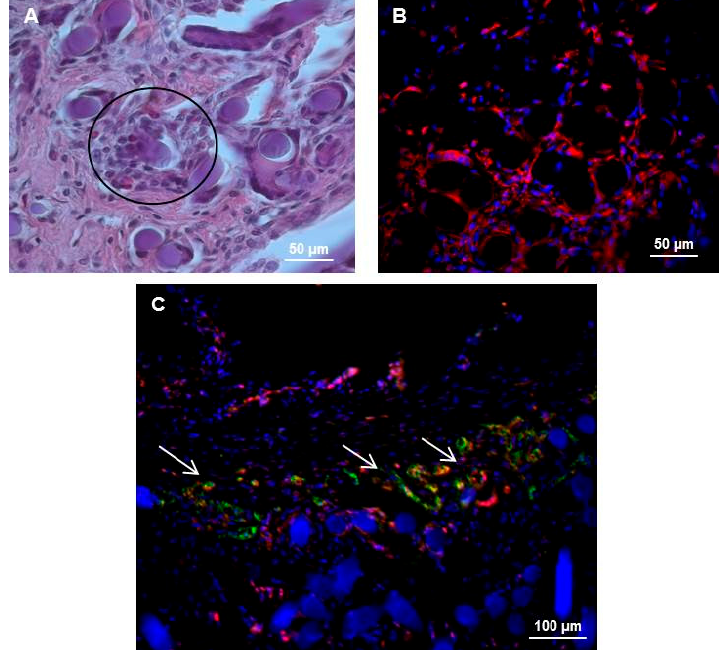
Figure 6. ( A ) The hematoxylin and eosin (H&E) staining of pocket-scaffold enriched with rat hepatocytes and hMSCs showing the presence of hepatocytes (black circle) organized into clusters inside the HA fibers of the pocket-scaffold; ( B ) Immunofluorescence (IF) staining of Vimentin (red) in pocket-scaffold enriched with rat hepatocytes and hMSCs revealing cytoskeleton of mesenchymal cells. Nuclei (blue) stained with Hoechst; ( C ) Double IF staining showing VWF-positive endothelial cells (green) and CD73-positive hMSCs (red) inside the scaffold. Cell nuclei and HA fibers are blue. Vessels are indicated by white arrows.